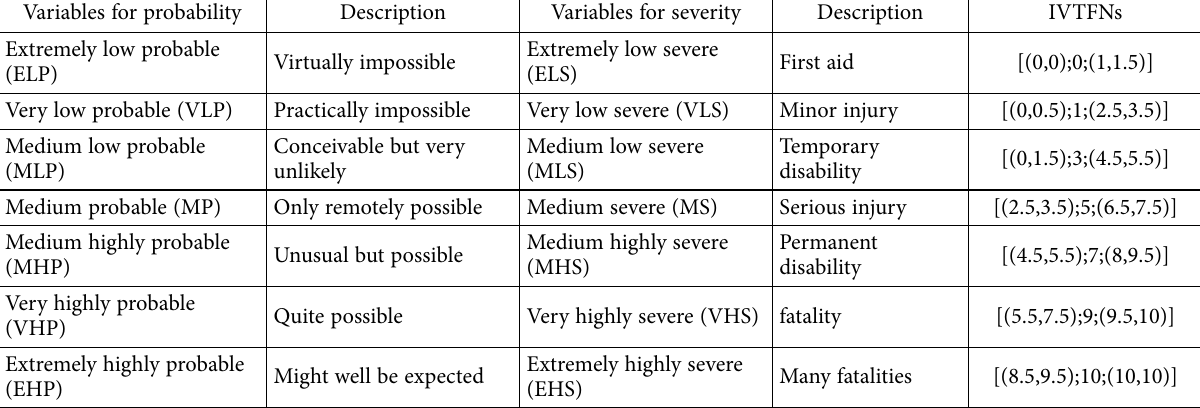
Table 2. Linguistic scales for the evaluation of risks with respect to the two risk parameters Variables for